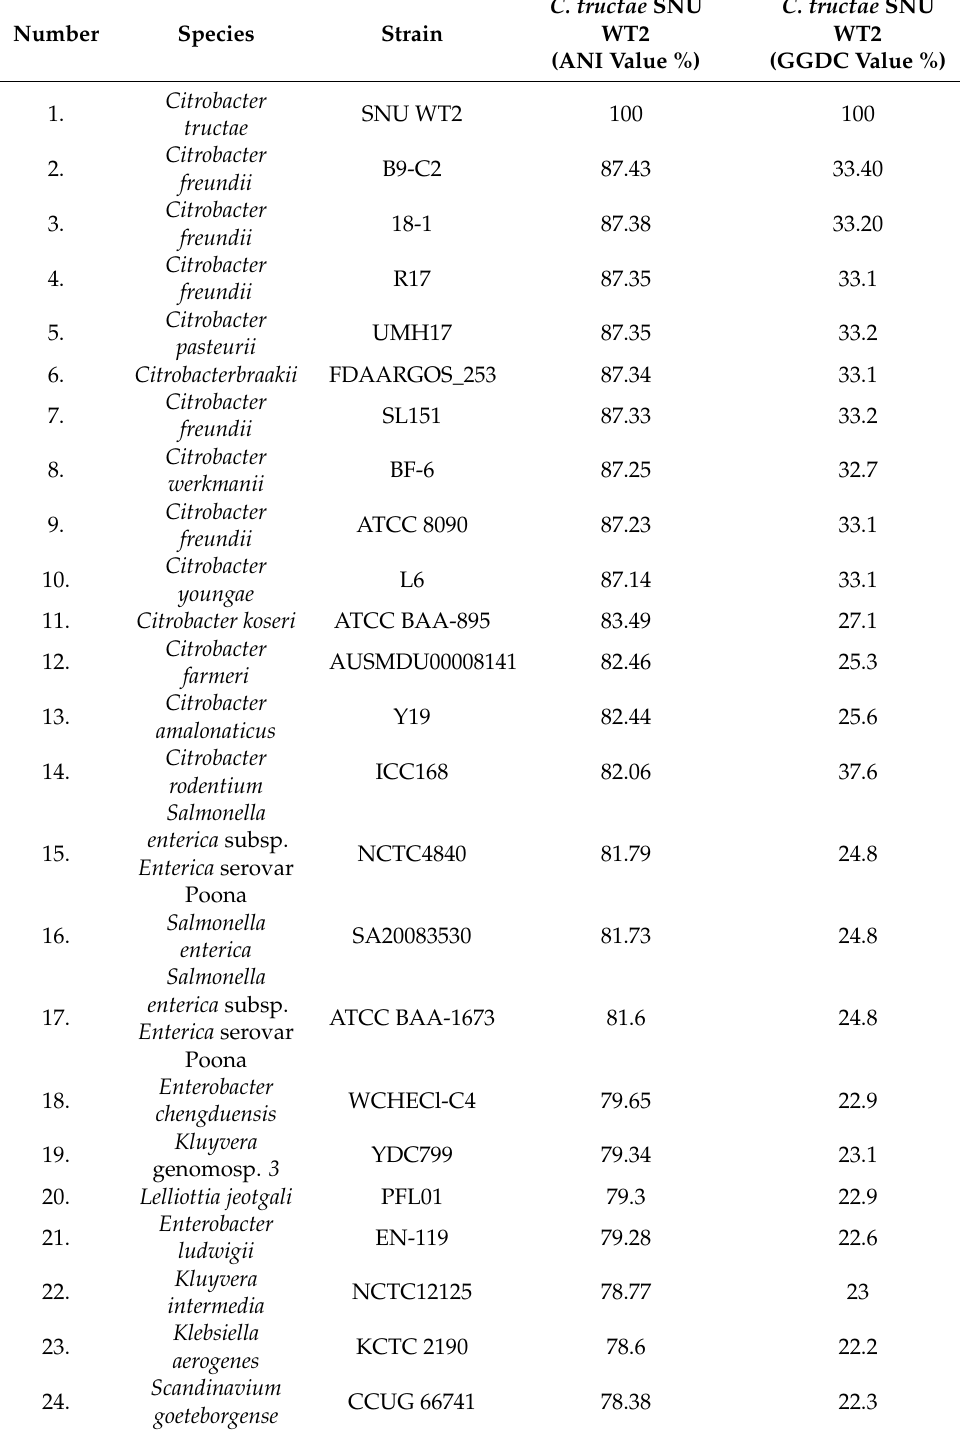
Table 1. Average nucleotide identity and genome-to-genome distance calculator (GGDC) analysis for Citrobacter tructae SNU WT2 and other related